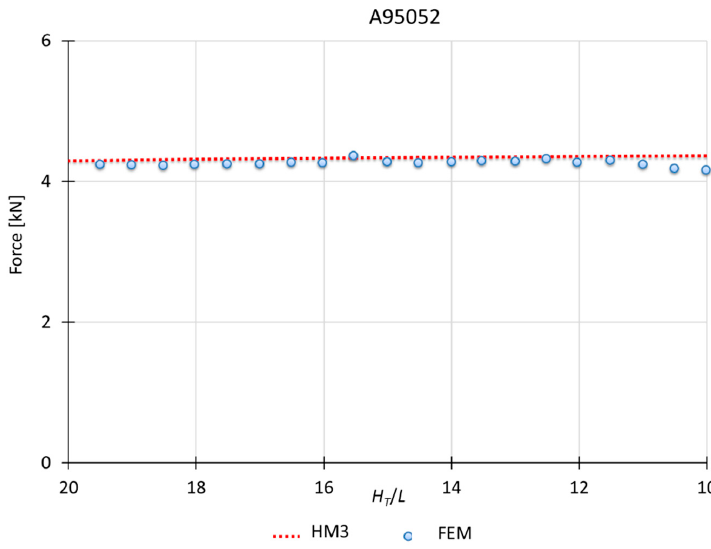
Figure 8. MUBT-FEM comparison for A95052, n = 0.09.